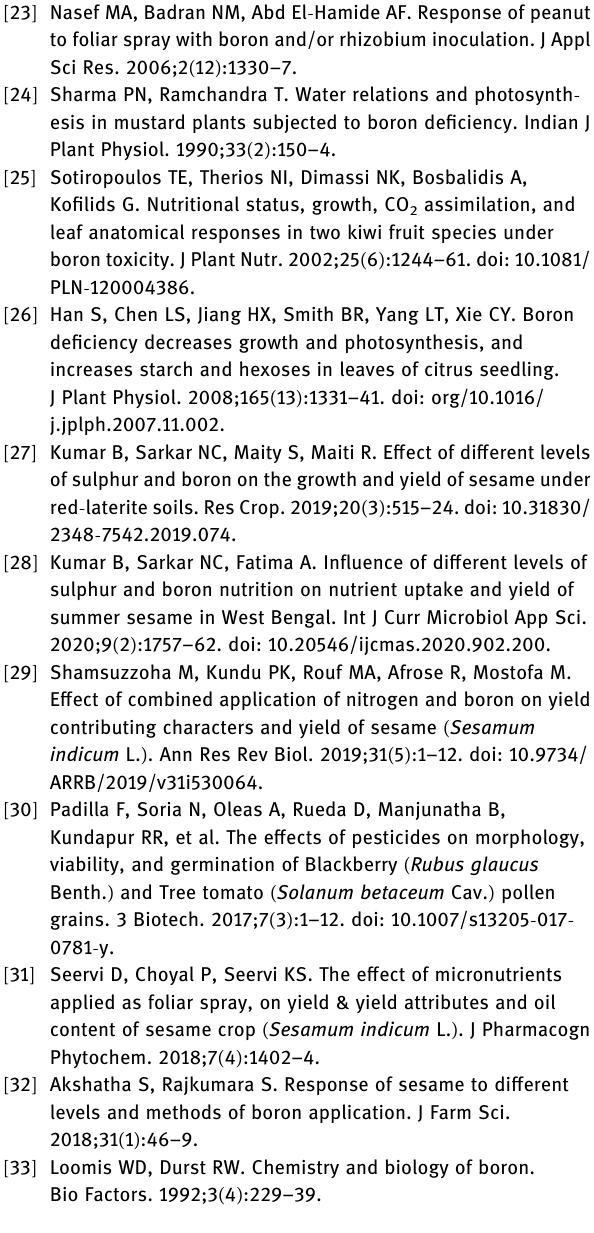
E ff ect of boron spray at di ff erent phenological stages on fruit set, mineral composition, and carbohydrates content of